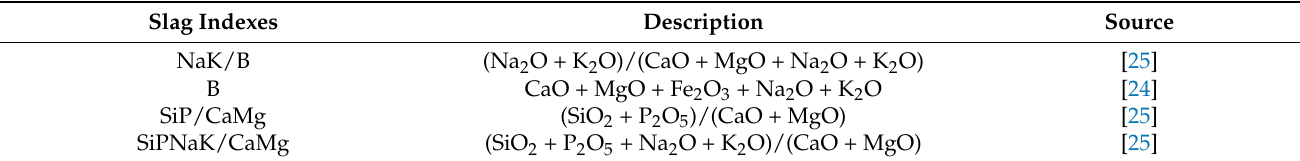
Table 2. Slag indexes based on ash chemical composition at 550 ◦ C and 1000 ◦